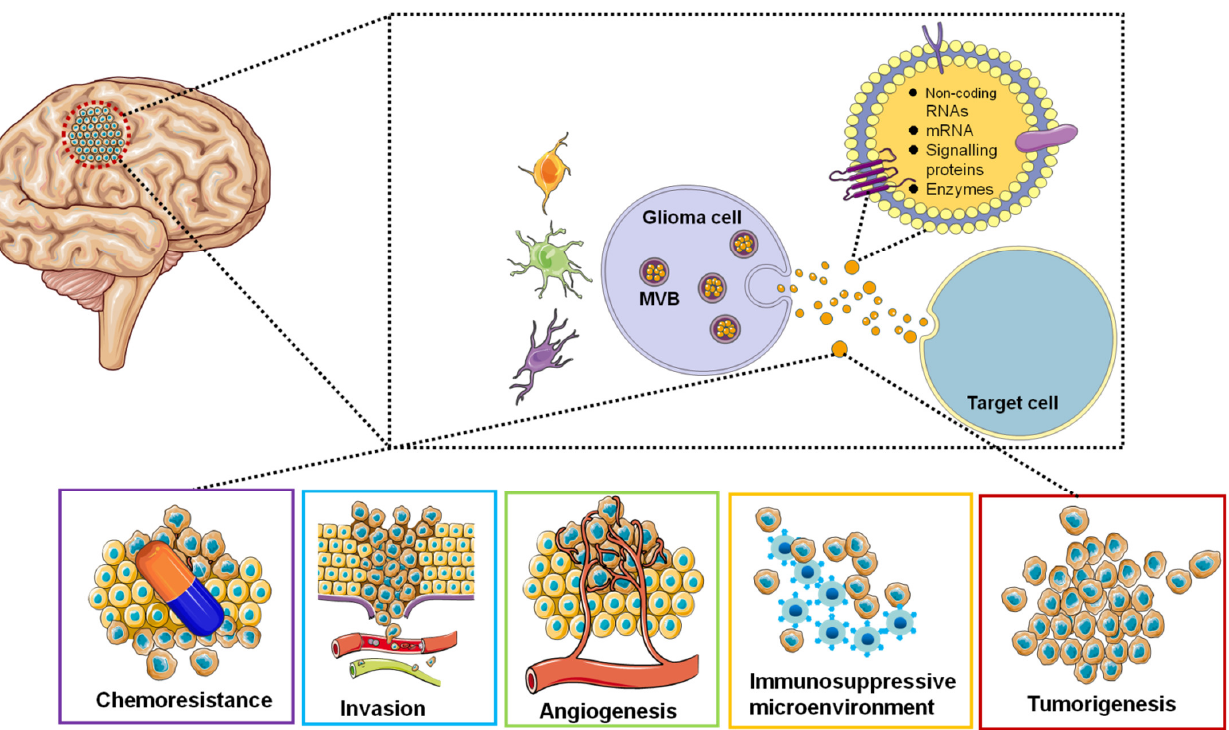
Figure 2. Functions of glioblastoma-derived EVs. EVs are involved in tumorigenesis, microenvironment, angiogenesis, immune response, invasion and chemoresistance by transferring oncogenic proteins and nucleic acids.